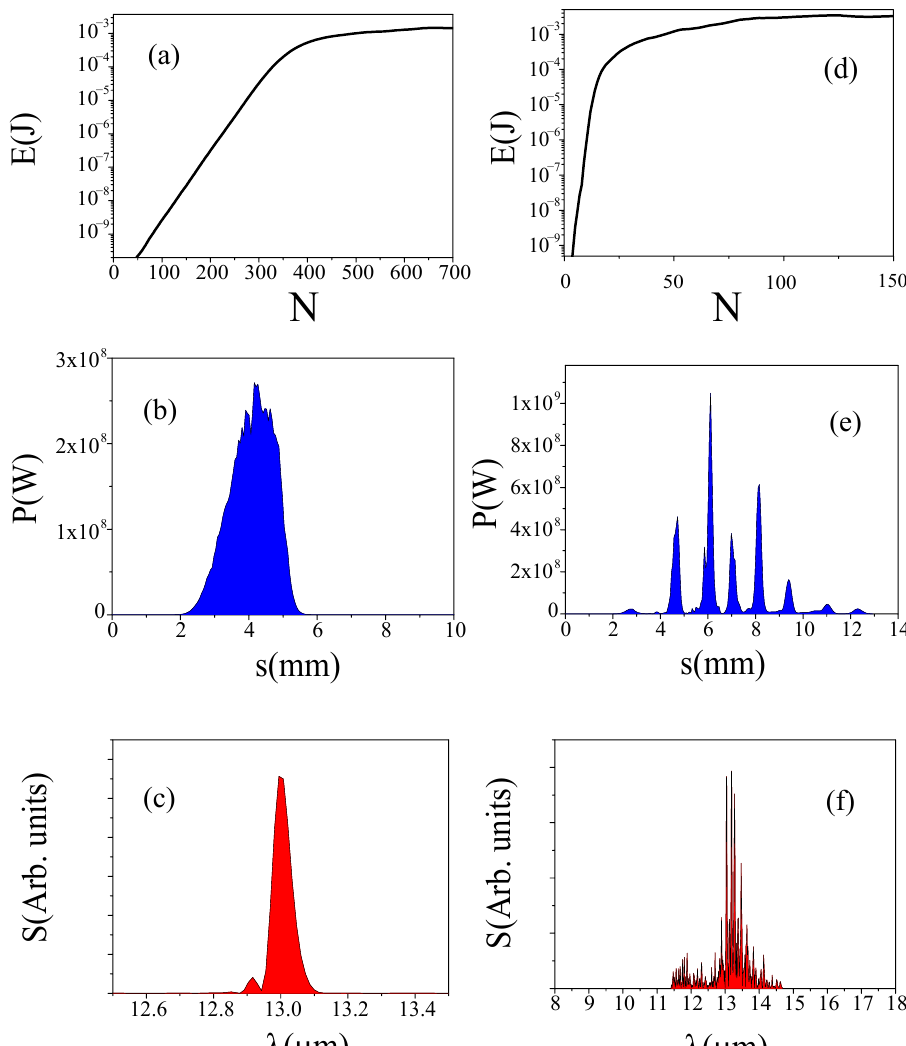
Figure 6. Radiation at λ = 13 µ m from an electron beam of 40 MeV with an undulator of period λ w = 2.8 cm. Left column: undulator length L w = 2 m. Right column: undulator length L w = 3 m. ( a , d ) Energy growth (J) as a function of the number N of shots; ( b , e ) power profile (W) vs. s (mm). ( c , f ) Spectral profile in arbitrary units vs. λ ( µ